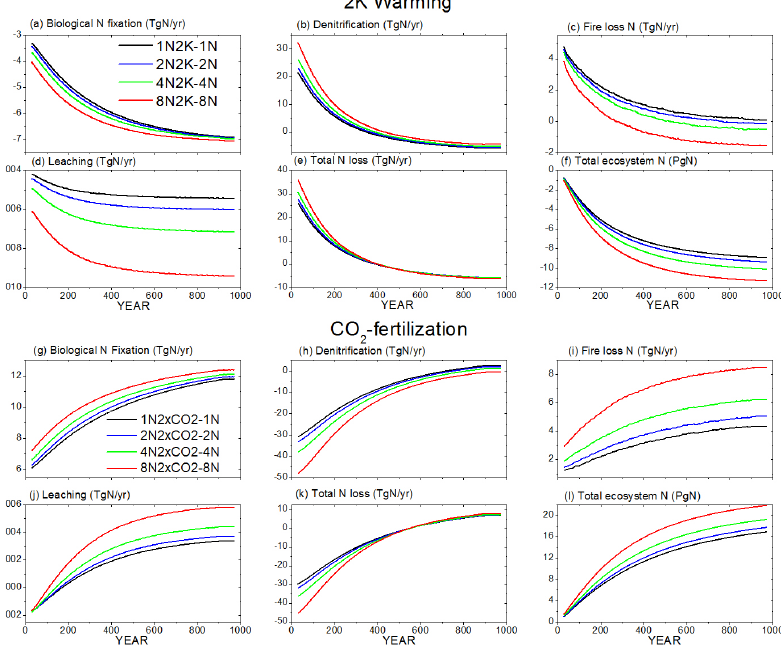
Fig. 6. Changes in N variables for the terrestrial ecosystem in the 1000yr simulations 1N (black line), 2N (blue line), 4N (green line) and 8N (red line) in presence of 2K warming (a–f) and CO 2 fertilization (g–l) : the global- and annual-mean changes of (a, g) biological N fixation (BNF), (b, h) denitrification, (c, i) fire loss N, (d, j) leaching, (e, k) total N loss from ecosystem (sum of denitrification, fire loss N and leaching) and (f, l) total ecosystem N (TEN). The order of magnitude of N fluxes indicates that denitrification flux is the dominant process controlling N stock changes. We find that the TEN losses in (e) are higher in the presence of 2K warming at higher N deposition levels due to larger decline in biological N fixation (a) and increase in denitrification (b) . In the case of CO 2 fertilization, TEN gains are larger at higher N deposition levels because of a larger increase in BNF and decline in denitrification.